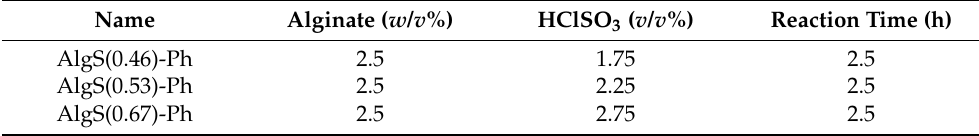
Table 1. Concentrations of alginate and HClSO 3 and reaction time for preparing of